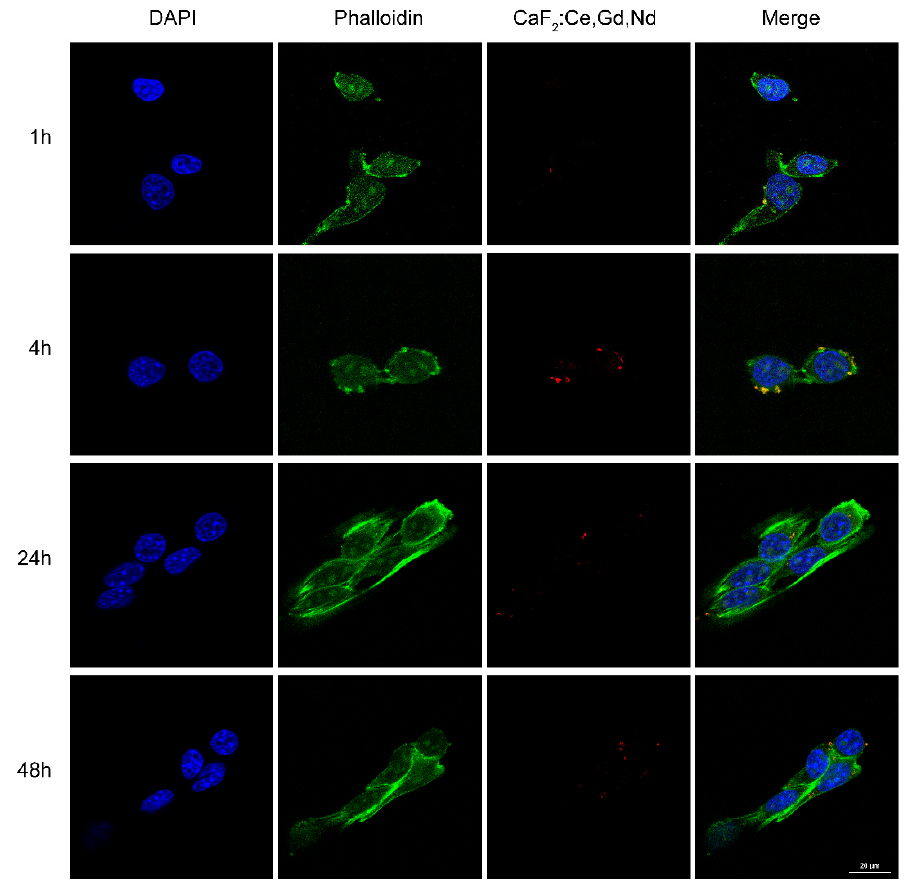
Figure 5. Uptake of CaF 2 : Ce, Gd, Nd NPs by 4T1 cells. Representative confocal microscopy images showing the uptake of CaF 2 : Ce, Gd, Nd NPs after 1 h, 4 h, 24 h and 48 h of incubation at 37 °C. Cell nuclei (blue), actin cytoskeleton (green), CaF 2 : Ce, Gd, Nd NPs (red). Scale bar = 20 μ m.